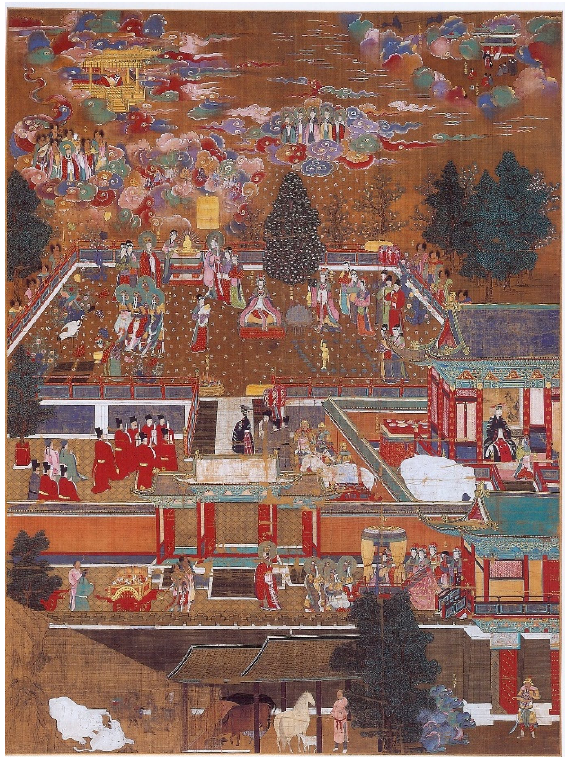
Figure 17. Birth of Sakyamuni, Joseon dynasty (latter half of 15th century), 145.0 × 109.5 cm, Hongakuji 本岳寺 Temple, Fukuoka, Japan (Photo by Jeong Utaek).